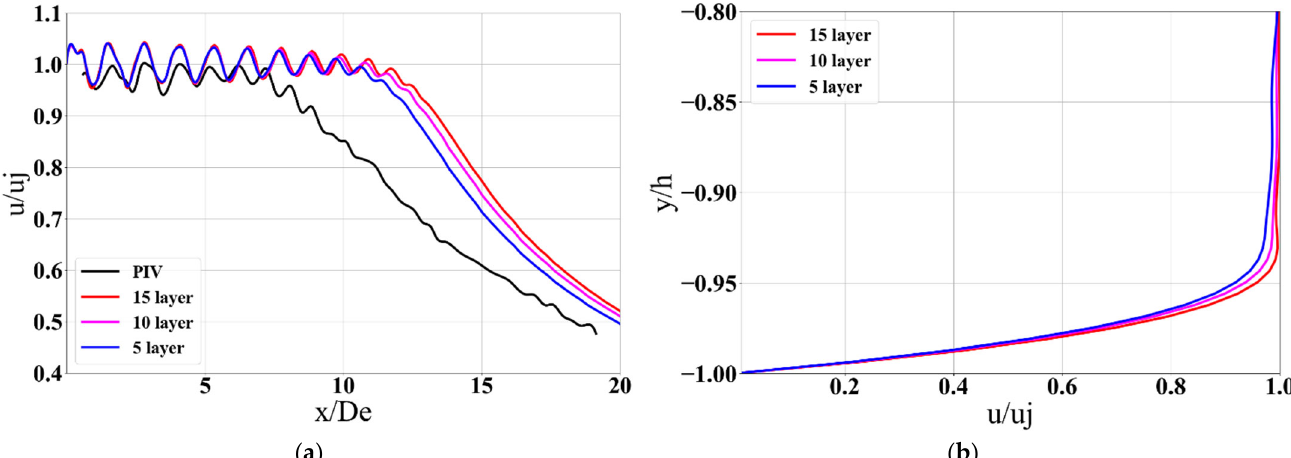
Figure 9. Prism layer sensitivity. ( a ) Jet centerline velocity compared with PIV data from [60]. ( b ) Boundary layer profiles at nozzle exit.